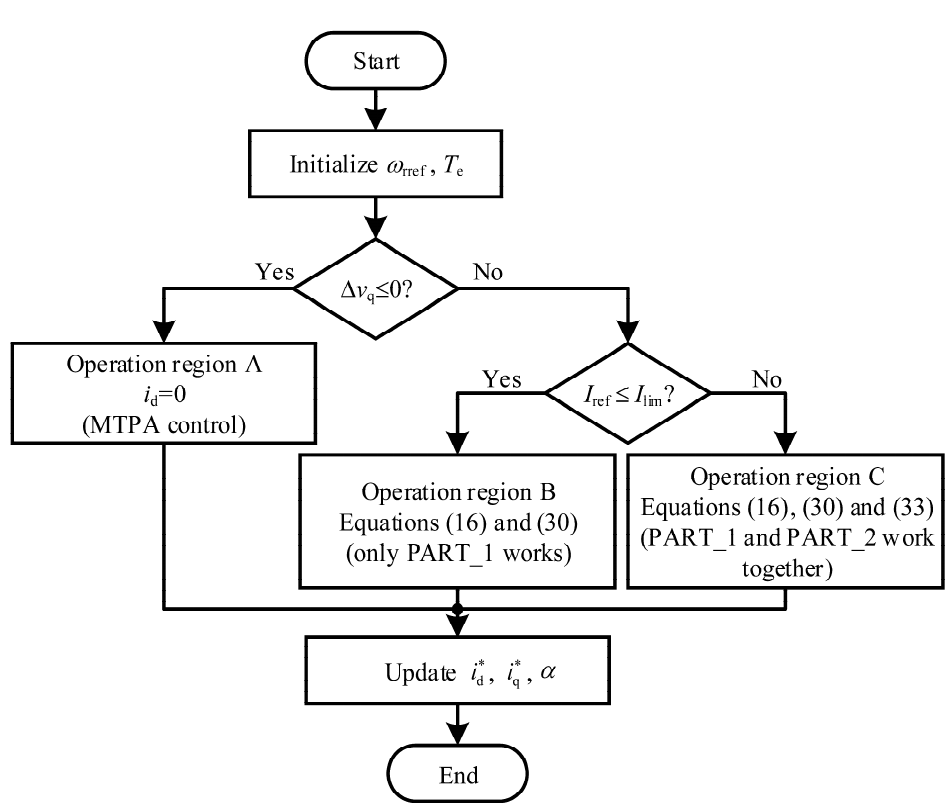
Figure 7. Flowchart of the proposed flux-weakening control strategy.